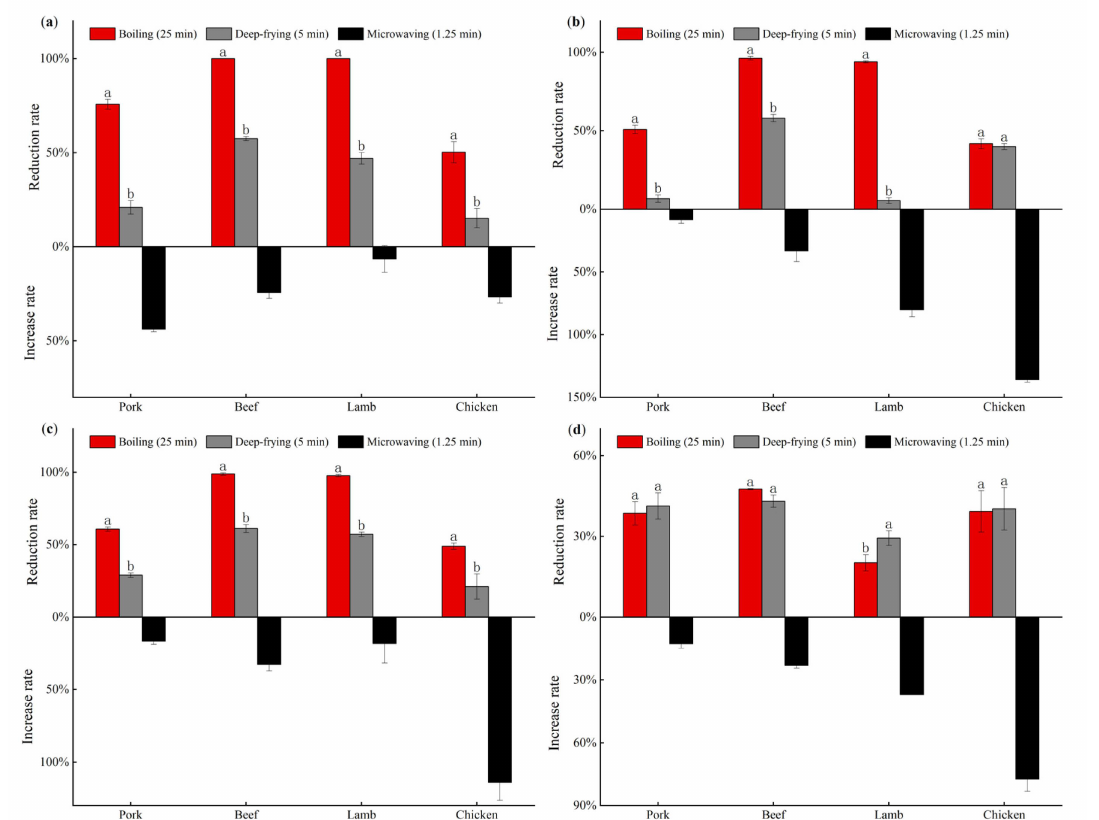
Figure 3. The rate of change in residue concentrations of amphenicols and metabolites in livestock and poultry meat under different cooking methods. ( a ) CAP; ( b ) TAP; ( c ) FF; ( d ) FFA. Different lowercase letters represent significant differences ( p < 0.05) in the reduction rate of the same drug in the same species of livestock and poultry meat under boiling (25 min) and deep-frying (5 min) treatments. The same lowercase letter indicates no significant difference ( p >